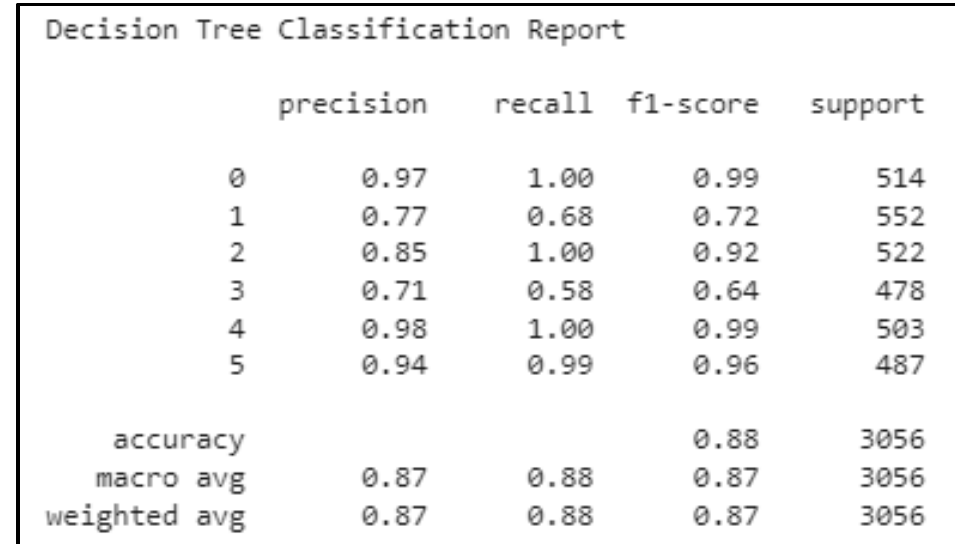
Figure 17. Confusion matrix of the decision tree.